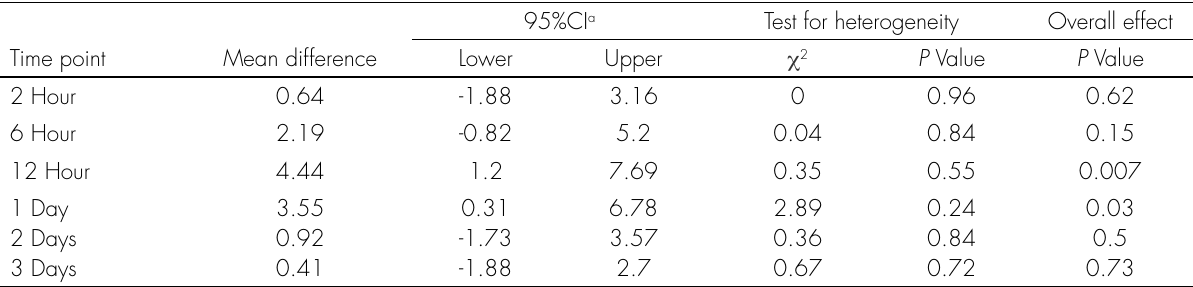
Table V. Meta-analysis data summary: CBT vs music